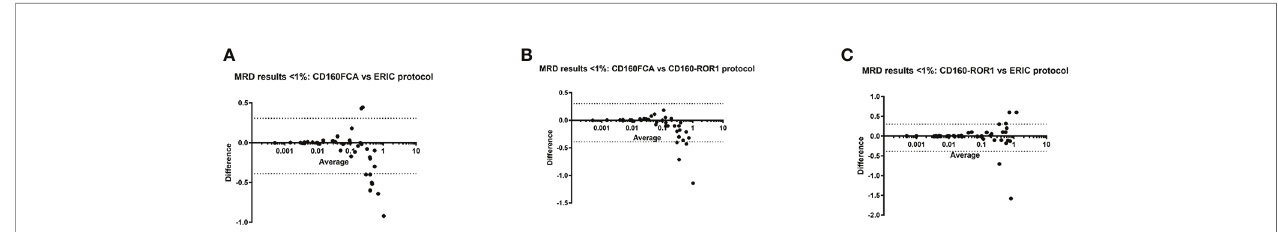
FIGURE 4 | Differences in MRD detection by CD160FCA, the ERIC protocol and CD160-ROR1FCA. Patient samples (n = 54/89) with MRD detection at low levels (< 1%) were subject to Bland-Altman comparison for differences in MRD detection. (A) CD160FCA vs ERIC: Bias: -0.04 (95%CI -0.39 to 0.30. (B) CD160FCA v CD160-ROR1 Bias: -0.05 (95%CI -0.37 to 0.28). (C) ERIC v CD160-ROR1 Bias: -0.002 (95%CI -0.42 to